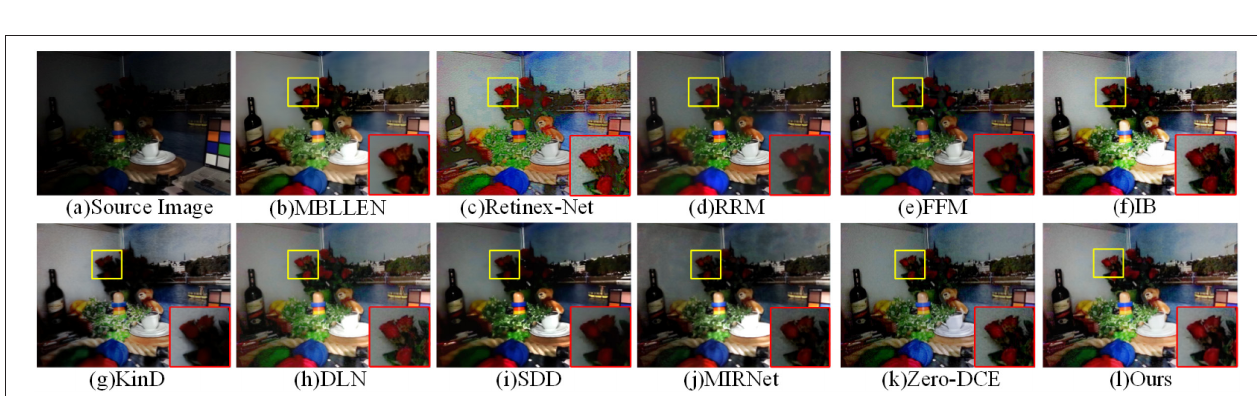
FIGURE 8 | Comparison of the visual effects of our method and other low-light enhancement methods in the DICM dataset. (A) is the original image, (B–K) is the other 10 low-light enhancement methods, and (I) is our method.